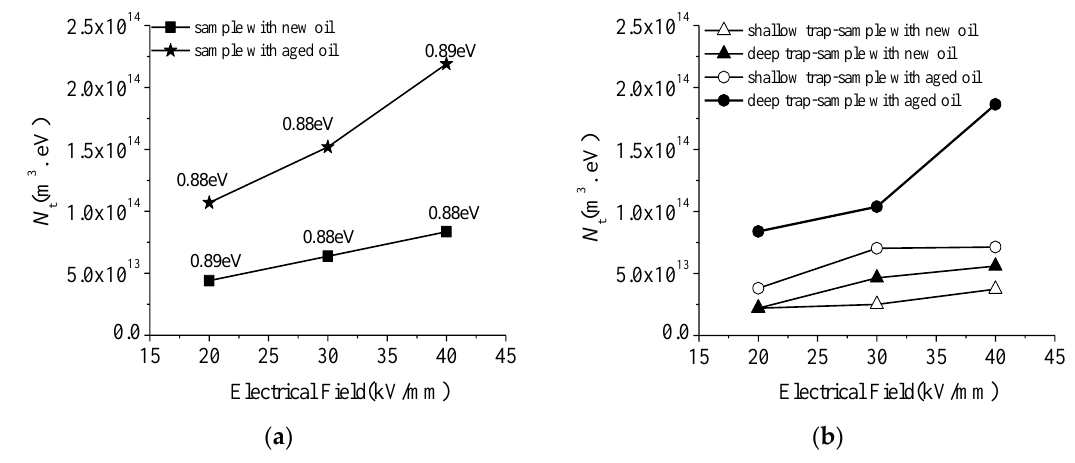
Figure 11. Trap density changing with electric field strength for the sample with new and aged oil. ( a ) common method; ( b ) improved method.